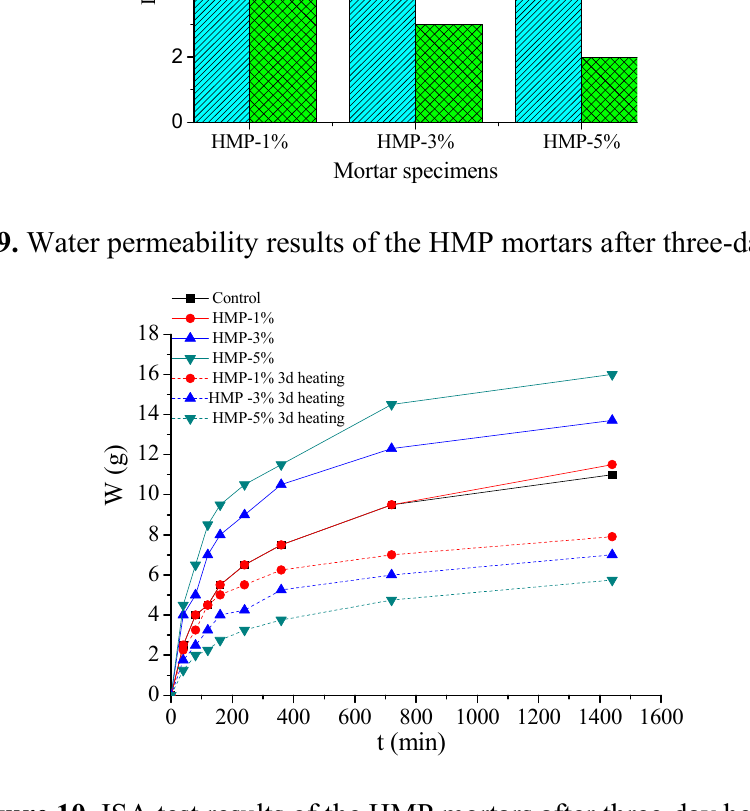
Figure 10. ISA test results of the HMP mortars after three-day